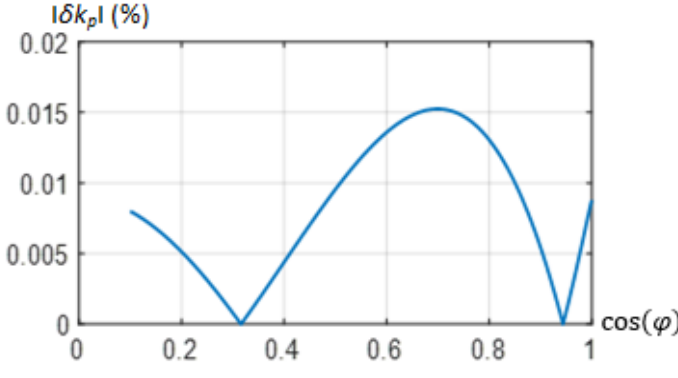
Figure 8. Error dependence on the wiring resistance 𝑅 𝑤 .